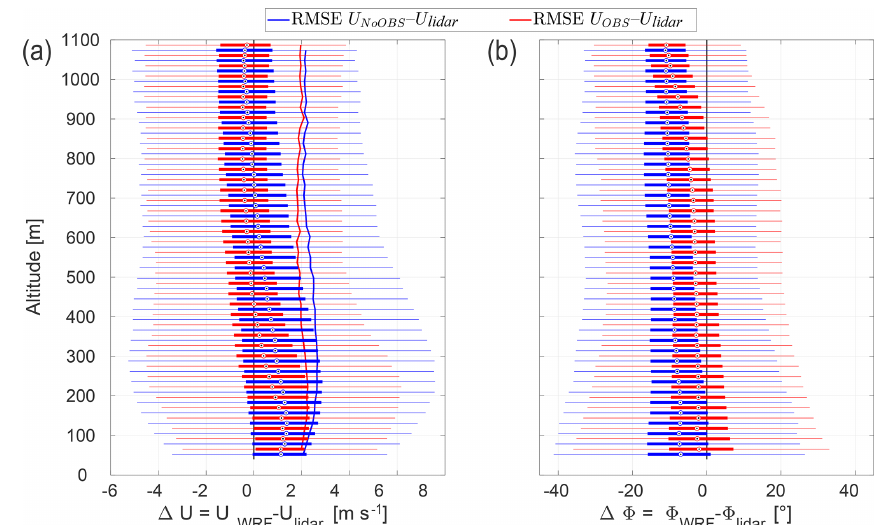
Figure 3. Statistical analysis of the bias between simulated and measured wind speed ( (cid:49)U ) and direction bias ( (cid:49)(cid:56) ). The circle corresponds to the median, the colored box indicates the 25th and 75th percentile, and the whiskers mark ± 2 . 7 σ . The solid lines in (a) show the RMSE between the modeled and measured wind